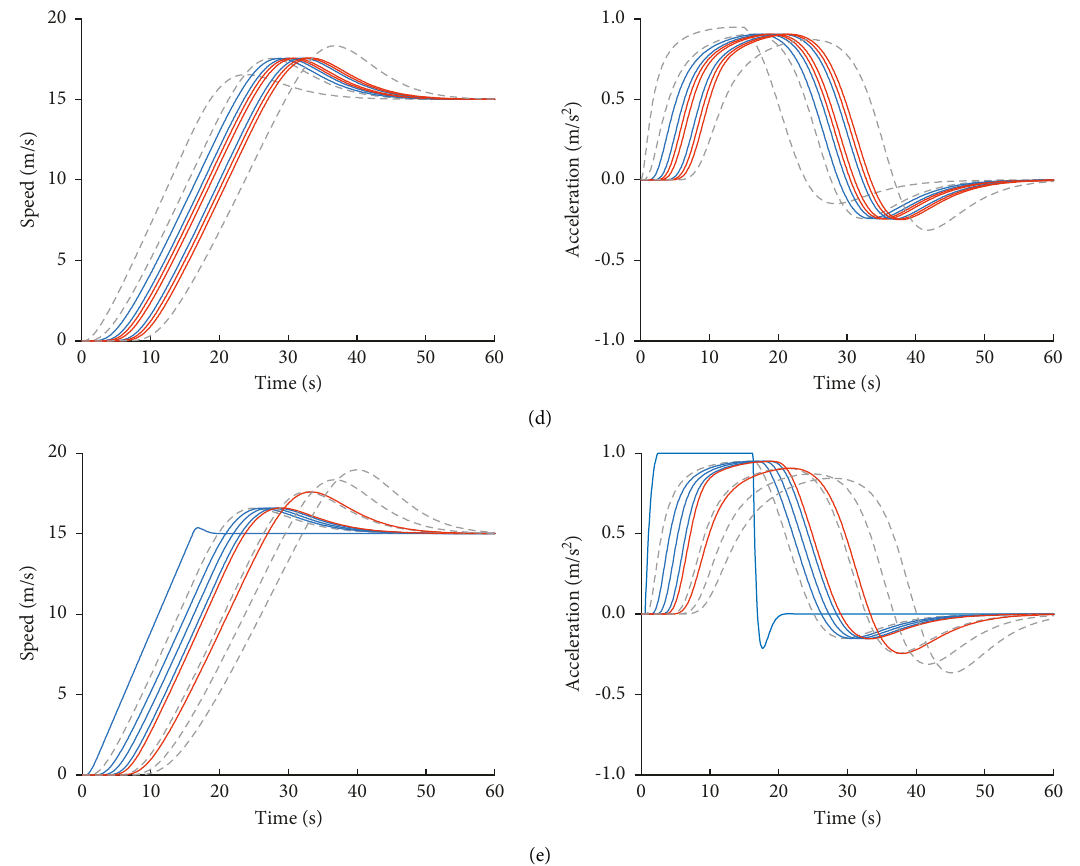
Figure 6: Vehicle dynamics with transmission delay during startup case. (a) p � 0. (b) p � 0 . 2. (c) p � 0 . 4. (d) p � 0 . 6. (e) p � 0 .